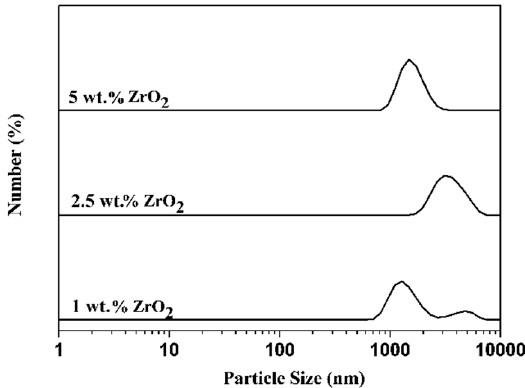
Figure 3. Distribution of particle size for ZrO 2 -silane solution at the different percentages of nanoparticles (1 wt.%, 2.5 wt.%, and 5 wt.%) by DLS.